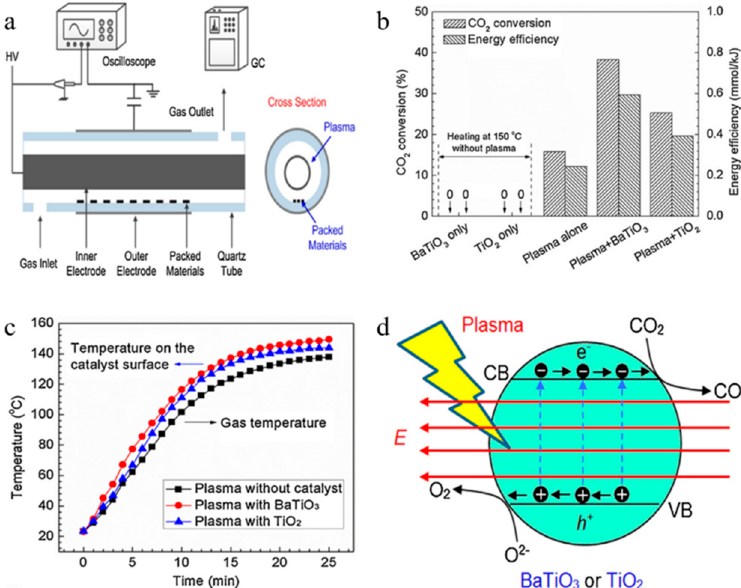
Figure 7. ( a ) diagram of reaction experimental device; ( b ) impact of plasma and catalyst on CO 2 conversion; ( c ) changes in plasma gas temperature and catalyst surface temperature; ( d ) reaction mechanisms of photocatalytic decomposition of CO 2 by plasma. Reproduced with permission from [101]; Copyright Elsevier, 2016.